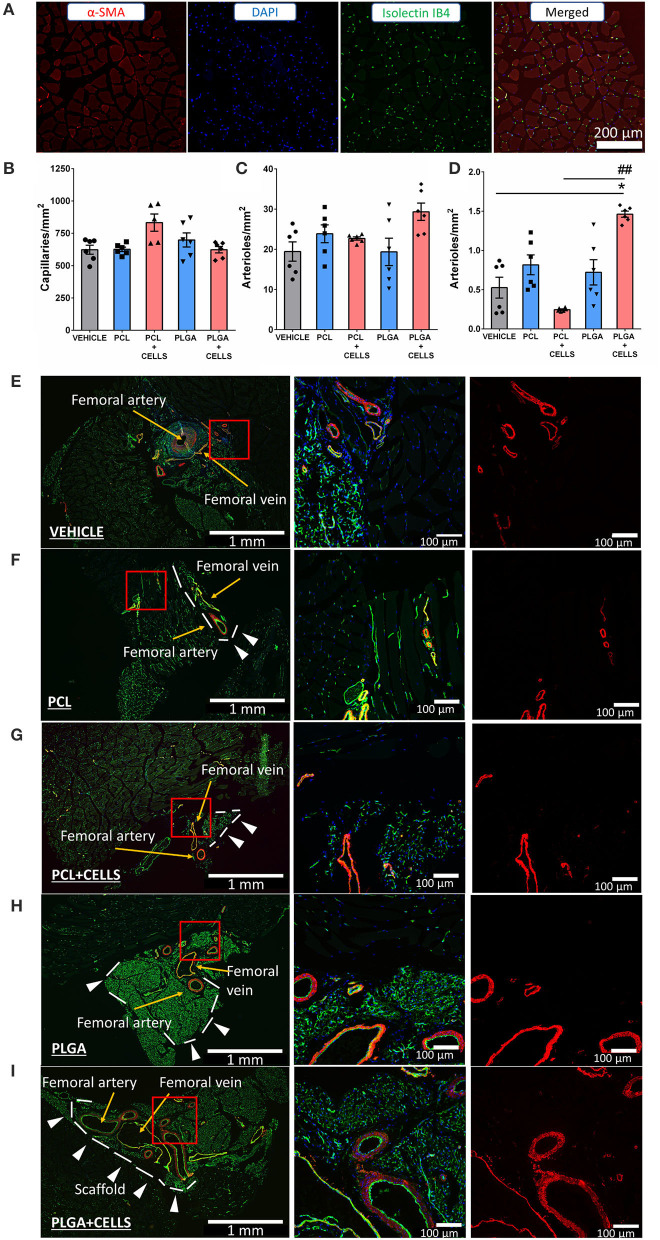
Angiogenesis assessment. (A) Representative fluorescent microscopy image of staining used to detect capillaries in the ischemic leg. (B) Bar graph showing capillary density; (C,D) Bar graphs of arterioles counting in the perivascular area: (C) cumulative calculation of arterioles density; (D) calculation of arterioles with diameter >50 μm; (E–I) Representative images of perivascular area of the various groups: Vehicle group (E), PCL (F), PCL + CELLS (G), PLGA (H) and finally PLGA + CELLS group (I). White arrows indicate the scaffold. Yellow arrows indicate arterioles. *P < 0.05 vs. vehicle. ##P < 0.01 vs. PCL-AG/PL without cells; data expressed in mean ± SE; N = 6 per group. Groups: (1) Vehicle: induction of unilateral limb ischemia (LI) without treatment; (2) PCL: induction of LI and implantation of PCL-GL + AG/PL without cells; (3) PCL + CELLS: induction of LI and implantation of PLC-GL + AG/PL with cells; (4) PLGA: induction of LI and implantation of PLGA-GL + AG/PL without cells; (5) PLGA + CELLS: induction of LI and implantation of PLGA-GL+AG/PL with cells.